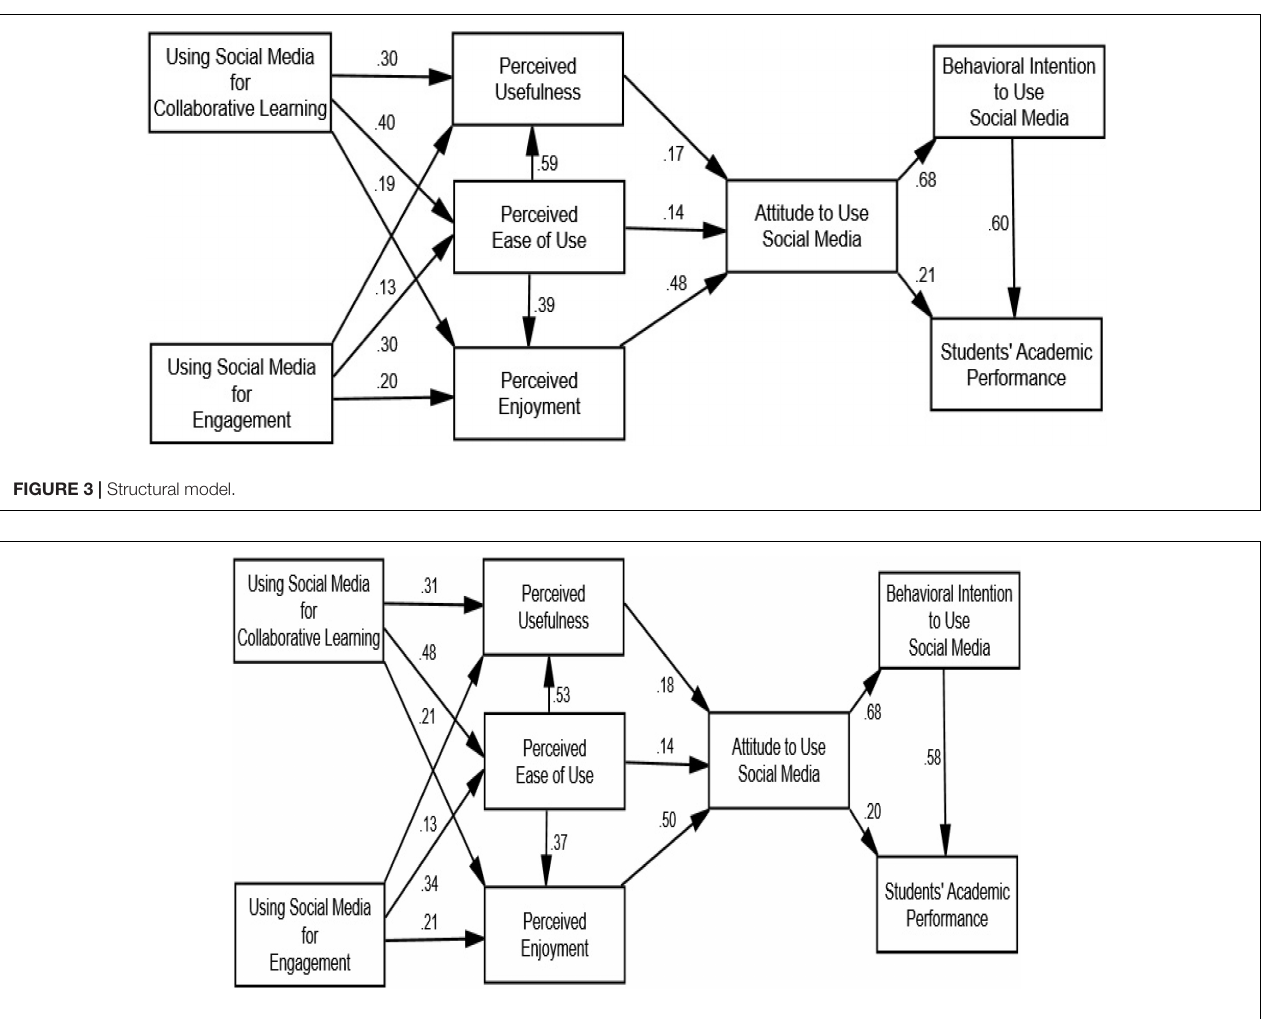
FIGURE 4 | Hypothesis